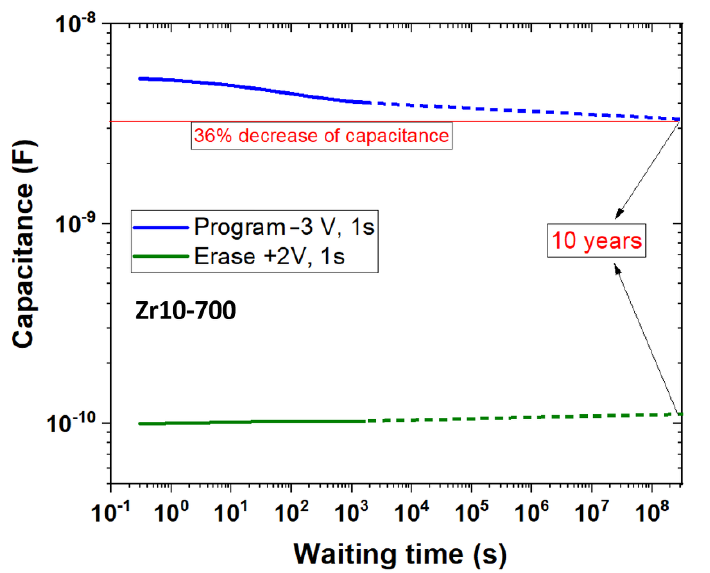
Figure 9. Charge retention characteristics measured at 500 kHz on the Zr10-700 sample. There is a 36% capacitance decrease after 10 years.